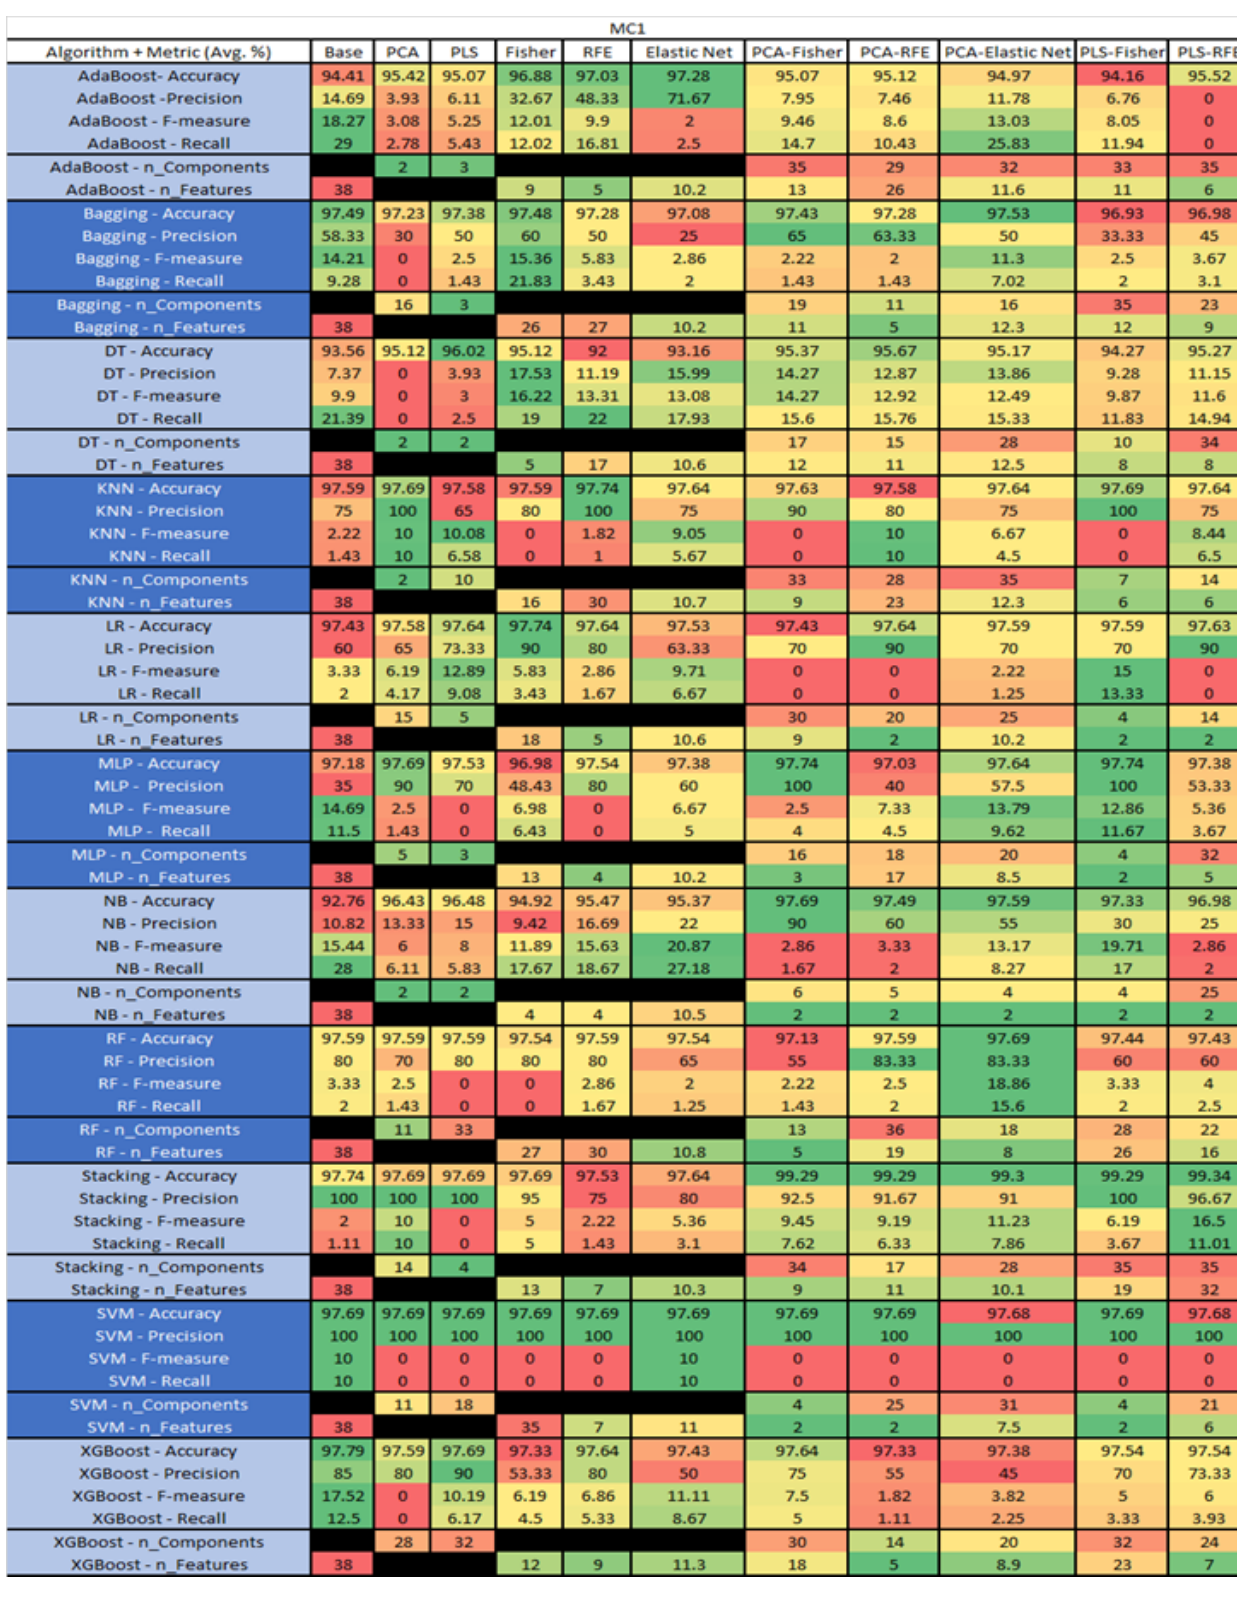
Figure 34. MC1 NASA MDP Results Data